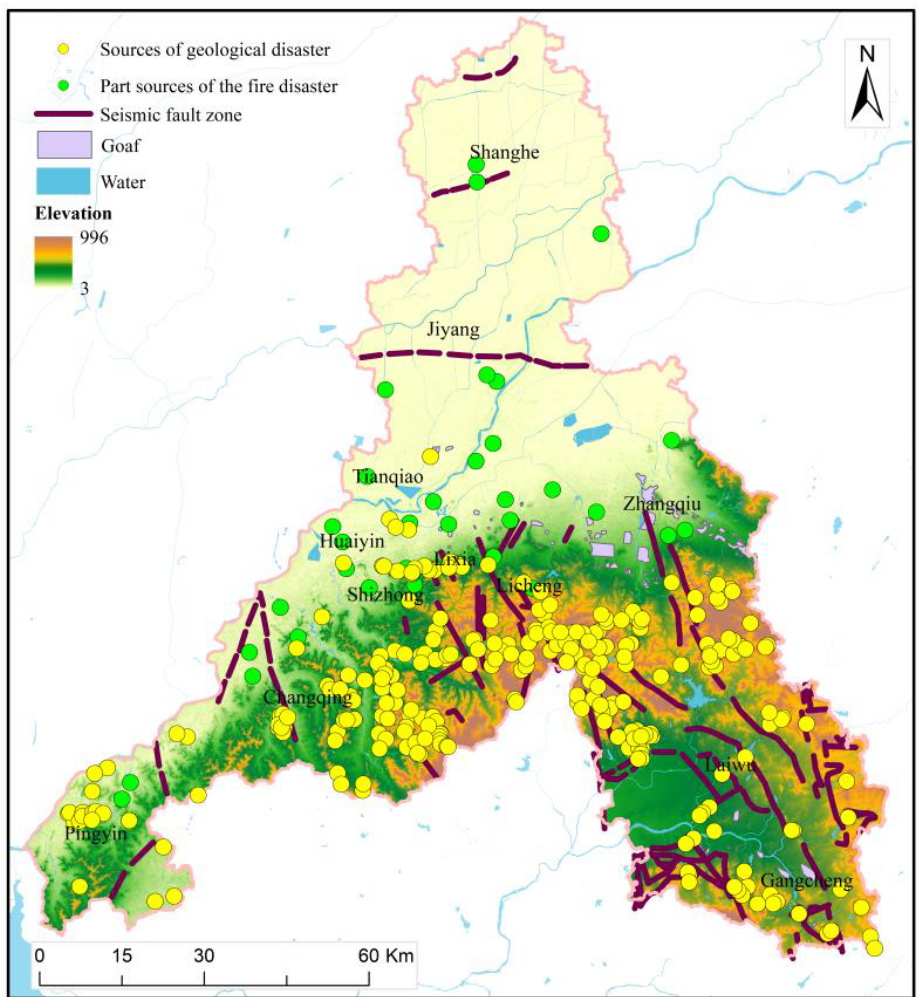
Figure 2. Part of disaster sources in Jinan.